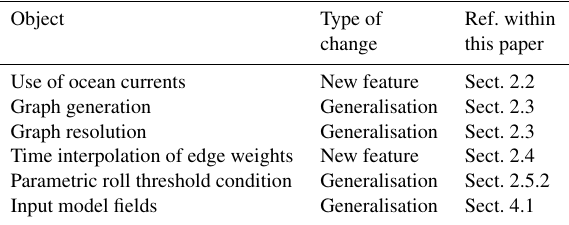
Table A1. List of main code changes of VISIR-1.b with respect to VISIR-1.a, with indication of their use within this paper. Object Type of Ref. within